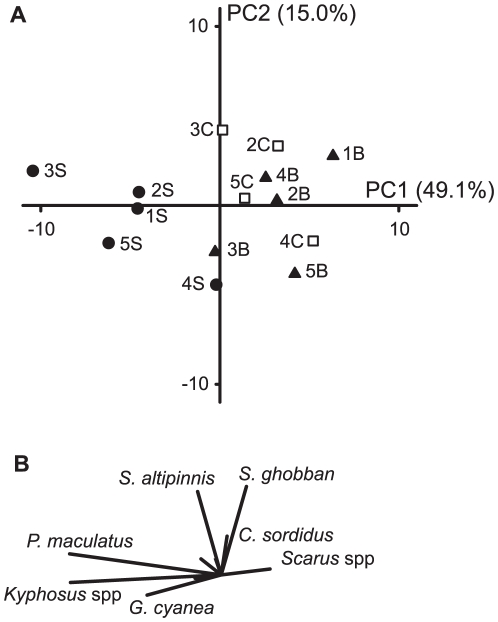
Principal component analysis showing the relationships among herbivorous fish assemblages on Lord Howe Island.(A) Ordination plot showing the relationship between fourteen locations. Each location is based on six 50-m belt transects. Symbols as for Figure 3. (B) Species loadings showing the relative contributions of each species to the observed differences in herbivorous fish community structure. Species names: Girella cyanea (Kyphosidae); Prionurus maculatus (Acanthuridae); Chlorurus sordidus, Scarus altipinnis, Scarus ghobban (Labridae).